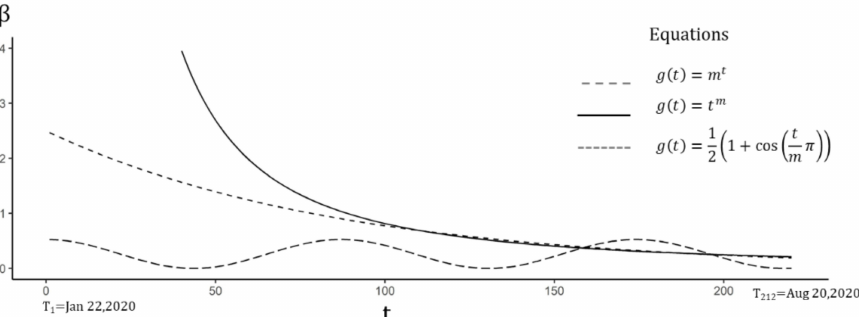
Figure 4. Time-varying TR estimated by Equation (16). Although the initial values of the power function were much higher than the exponential function in the medium term, the two values tended to be the same, while the periodic function showed that it was in the third